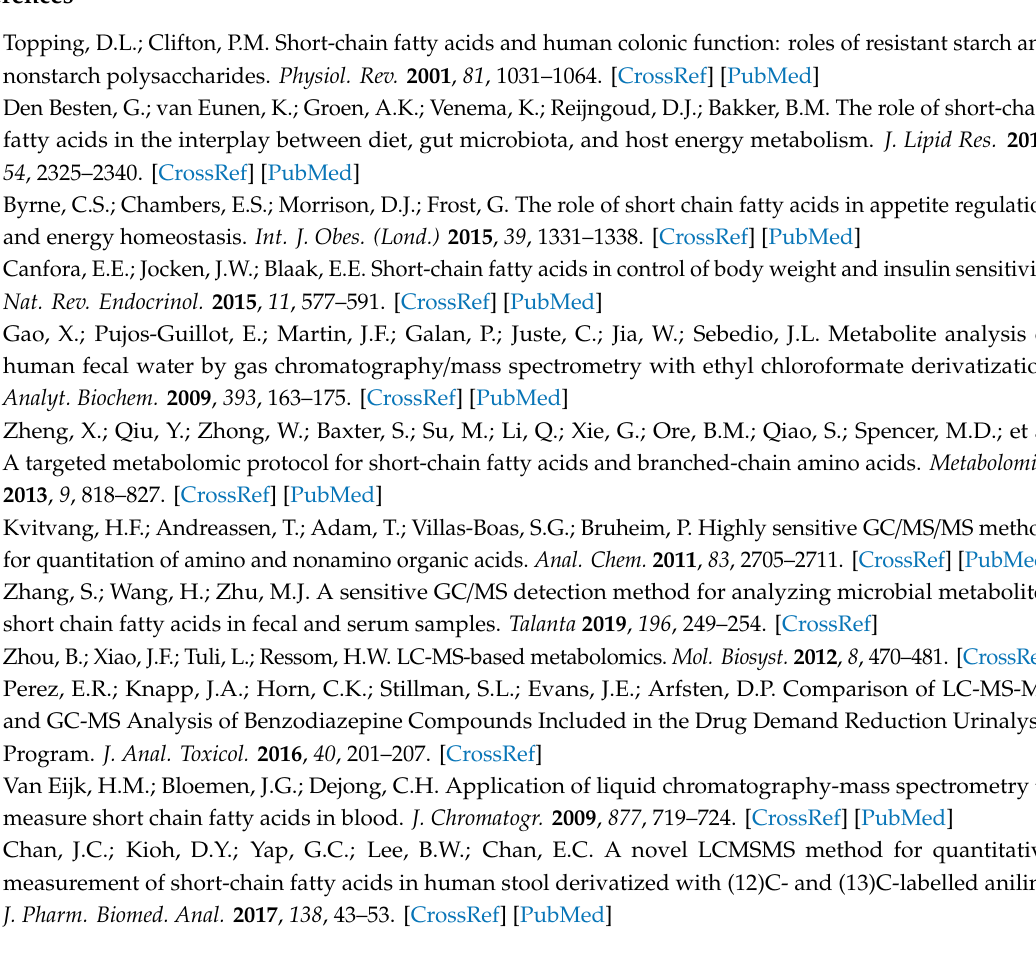
Table S1: Quantitation accuracies of spiked SCFAs in mouse feces, mouse plasma and human EBC. Figure S1: Tandem mass spectrometry (MS / MS) spectra of (A) derivatized acetic acid-2,2,2-d 3 (internal standard for C2), (B) derivatized valeric acid-2,2,3,3-d 4 (internal standard for C5), (C) derivatized Caproic acid-5,5,6,6,6-d 5 (internal standard for C6), Figure S2: Extracted ion chromatograms of SCFAs in (A) a standard solution (1 µ M) and (B) mouse feces (C) mouse plasma, and (D) human EBC, Figure S3: Calibration curves for 12 SCFAs, Figure S4: Extracted ion chromatograms of 12 SCFAs in a standard solution (10 µ M, 65 min. LC run